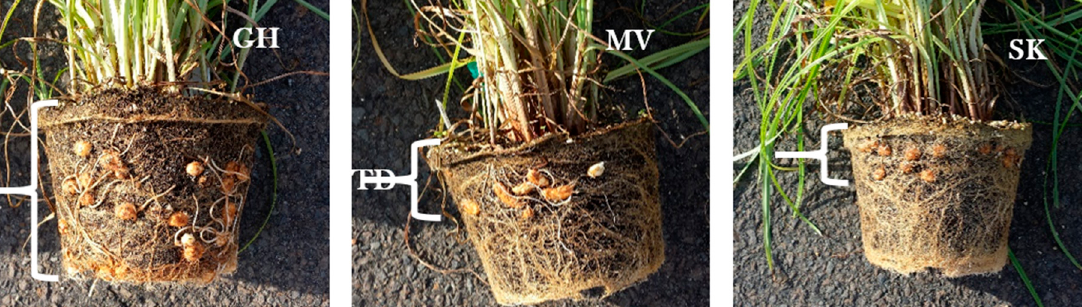
Figure 5. Tuber distribution in growth medium (Pro-Mix BX brand) at 12 weeks after transplanting in the GH, MV, and SK tigernut selections in the hoop house (See Table 1 for a full description of acronyms). The enclosure symbol shows the depth of tuber distribution (TD) in the growth medium (Photo: Albert Ayeni).